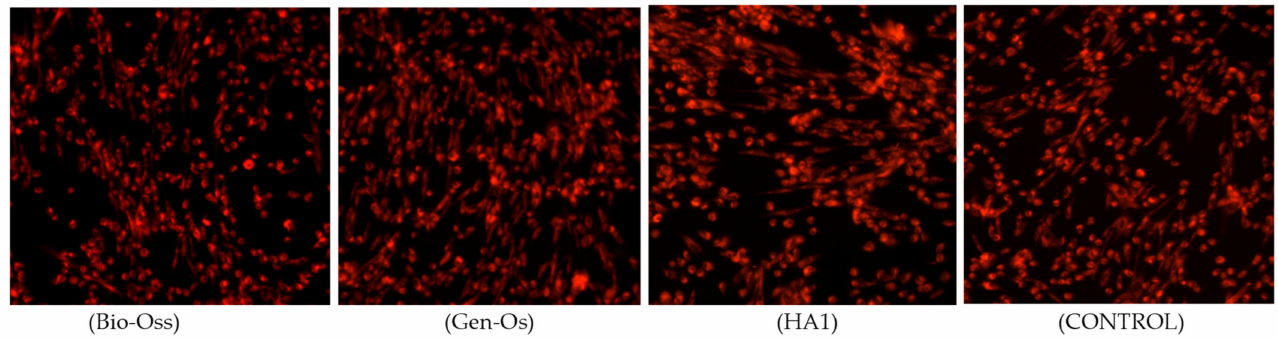
Figure 9. Fluorescent microscopy images of Bio-Oss, Gen-Os, HA1, and CONTROL colored with CMTPX